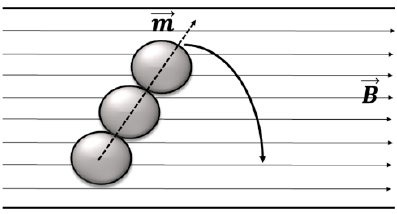
→ m , trying to align to an applied